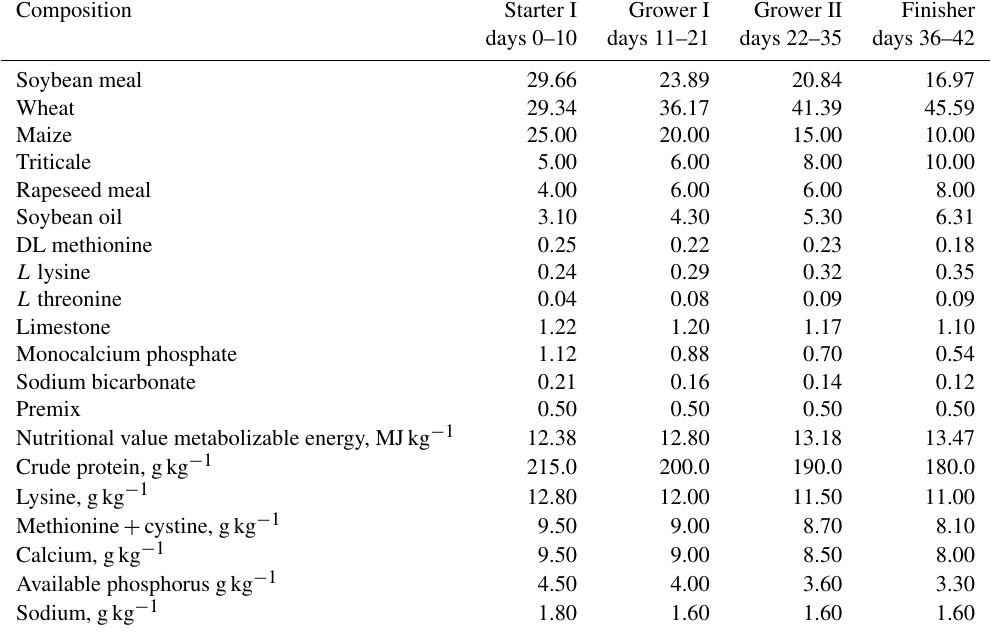
Table 1. Composition and nutritional value of diets for broiler chickens. Composition